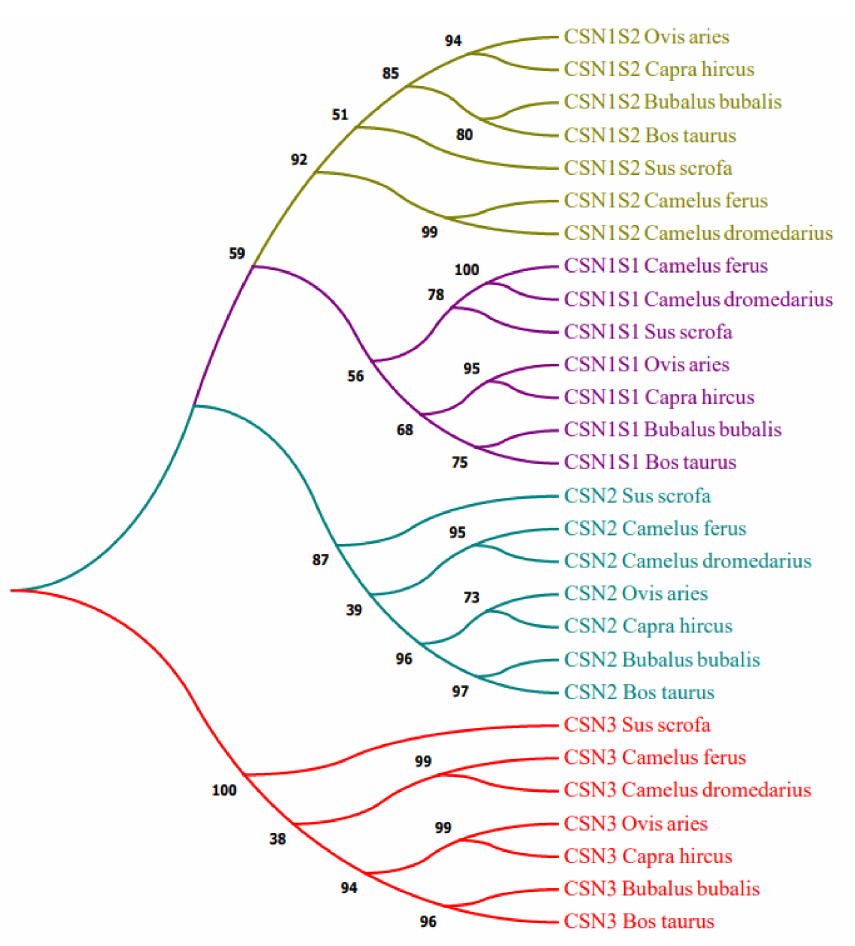
Figure 1. Phylogenetic relationship study of the casein gene family (purple: CSN1S1, olive green: CSN1S2, Teal: CSN2, and red: